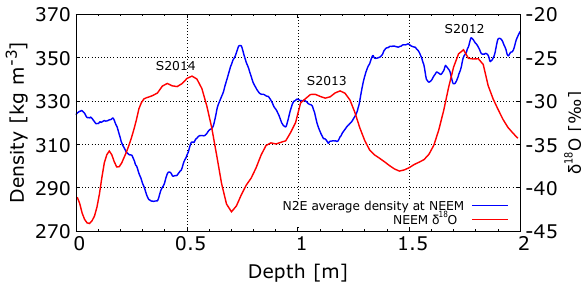
Figure 11. Comparison of the NEEM δ 18 O signal with the stacked density profile on the NEEM depth scale smoothed using 10cm run- ning means. The summer maxima for 2012–2014 were